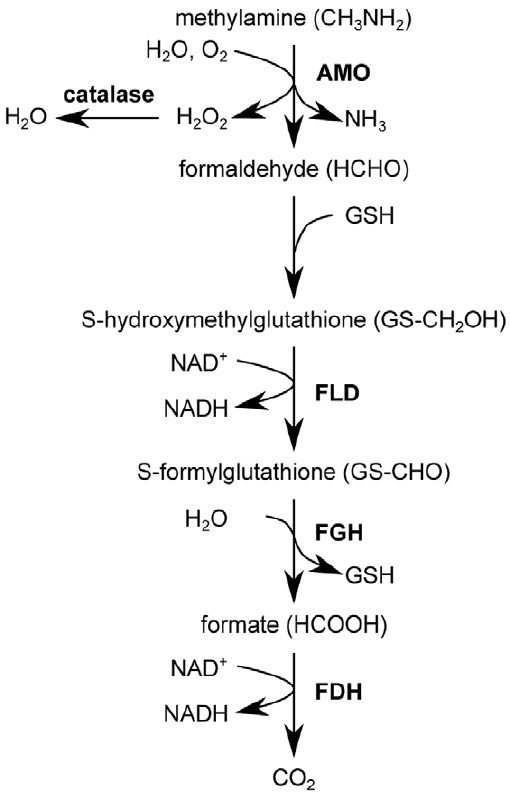
Figure 7. Schematic overview of MA metabolism in H. polymorpha . MA is oxidized by peroxisomal amine oxidase (AMO) to generate formaldehyde, ammonium and hydrogen peroxide. After binding of glutathione (GSH) to formaldehyde, the produced S- hydroxymethylglutathione is converted to S-formylglutathione by formaldehyde dehydrogenase (FLD). GSH is removed by S-formyl glutathione hydrolase (FGH) and formate is converted to CO 2 by formate dehydrogenase (FDH). Oxidation of formaldehyde generates 2 molecules of NADH that are used for ATP generation in mitochondria [30].